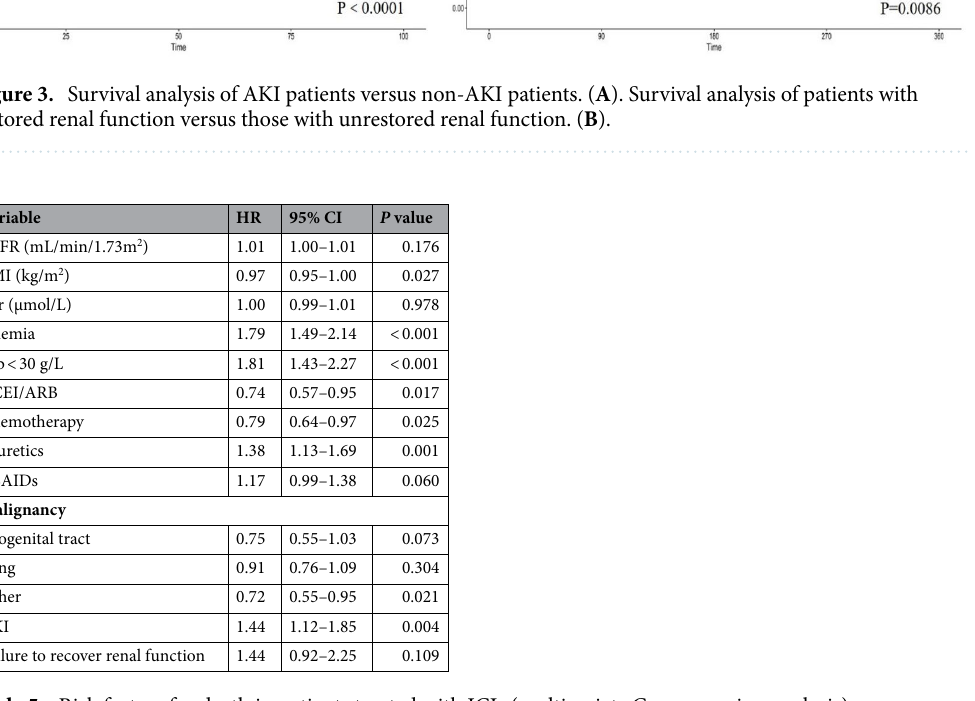
Table 5. Risk factors for death in patients treated with ICIs (multivariate Cox regression